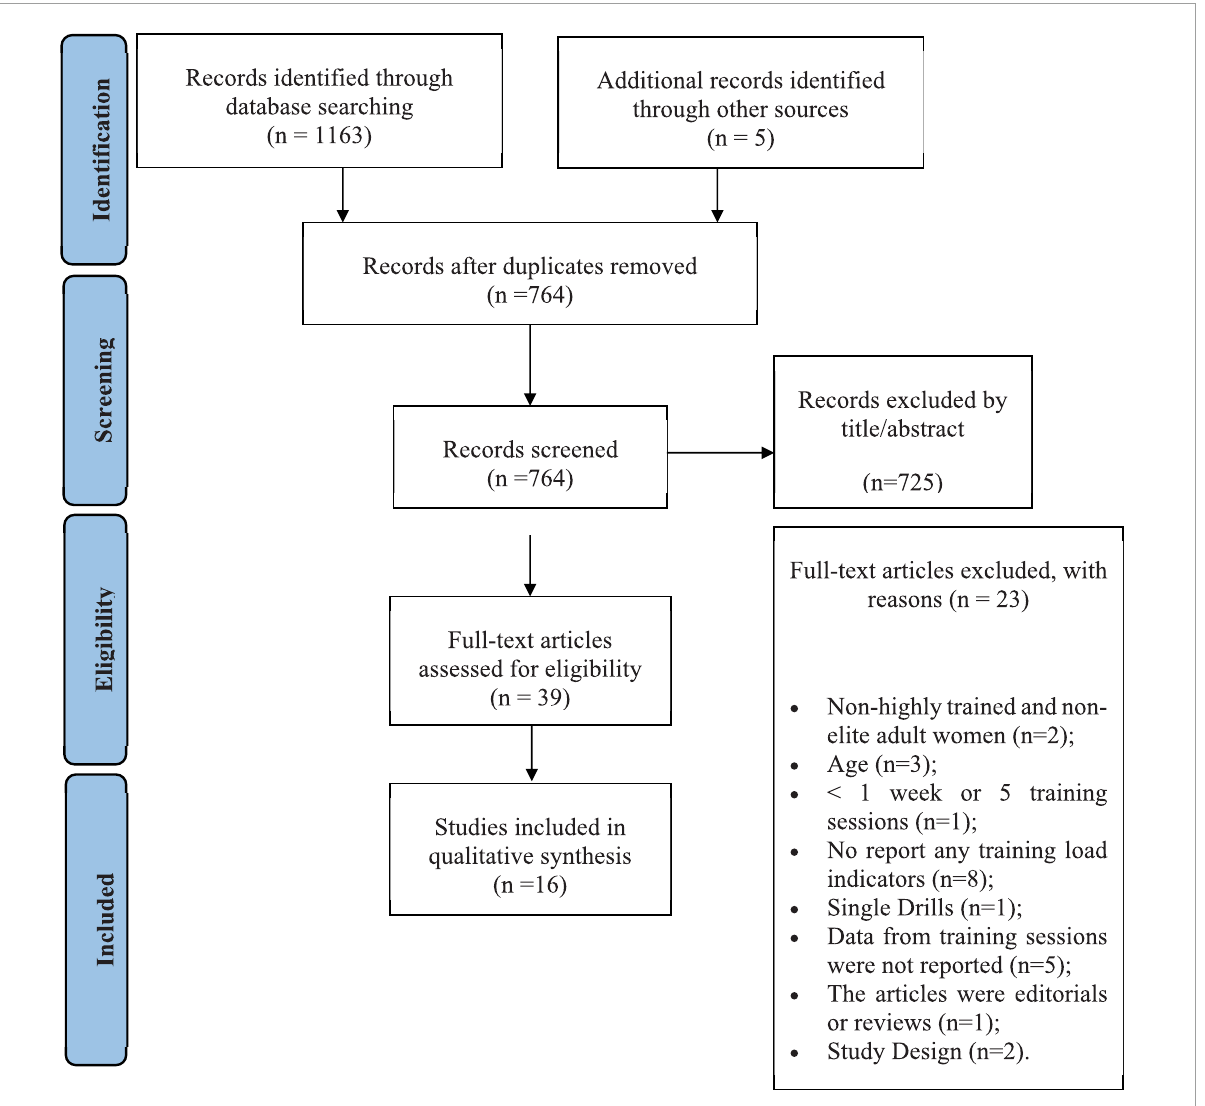
FIGURE1 Preferred reporting items for systematic reviews and meta-analyses (PRISMA) diagram of the literature search